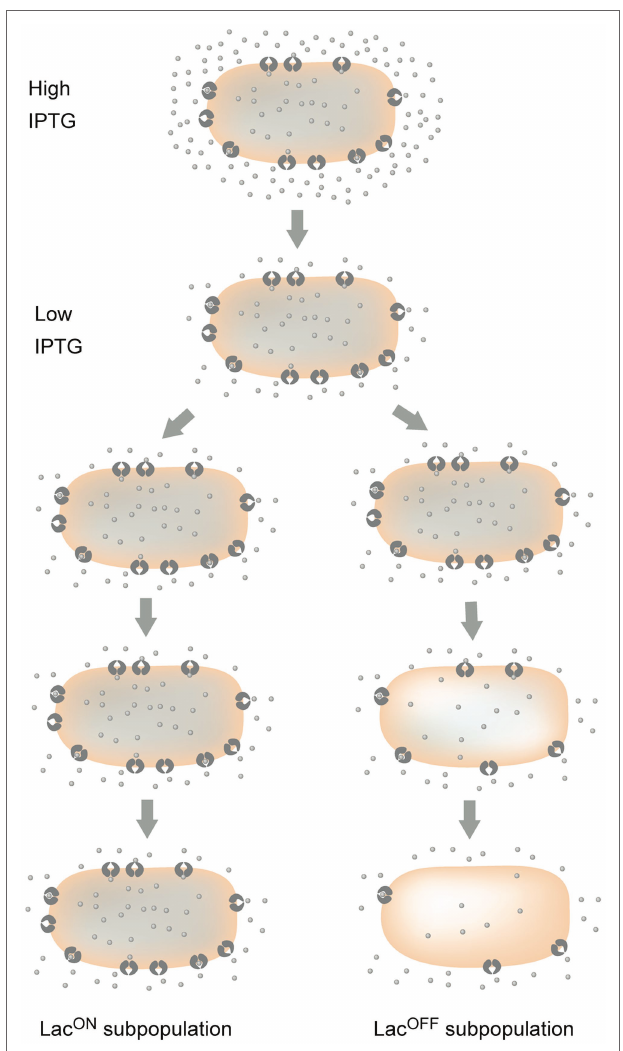
FIGURE 1 | Bifurcation of lac operon expression into ON and OFF states after transfer of an induced culture to lower and intermediate levels of the inducer, IPTG. LacI permease molecules are shown inserted in the cytoplasmic membrane. For simplification, the cell wall and the outer membrane are not shown. Dots represent IPTG molecules.